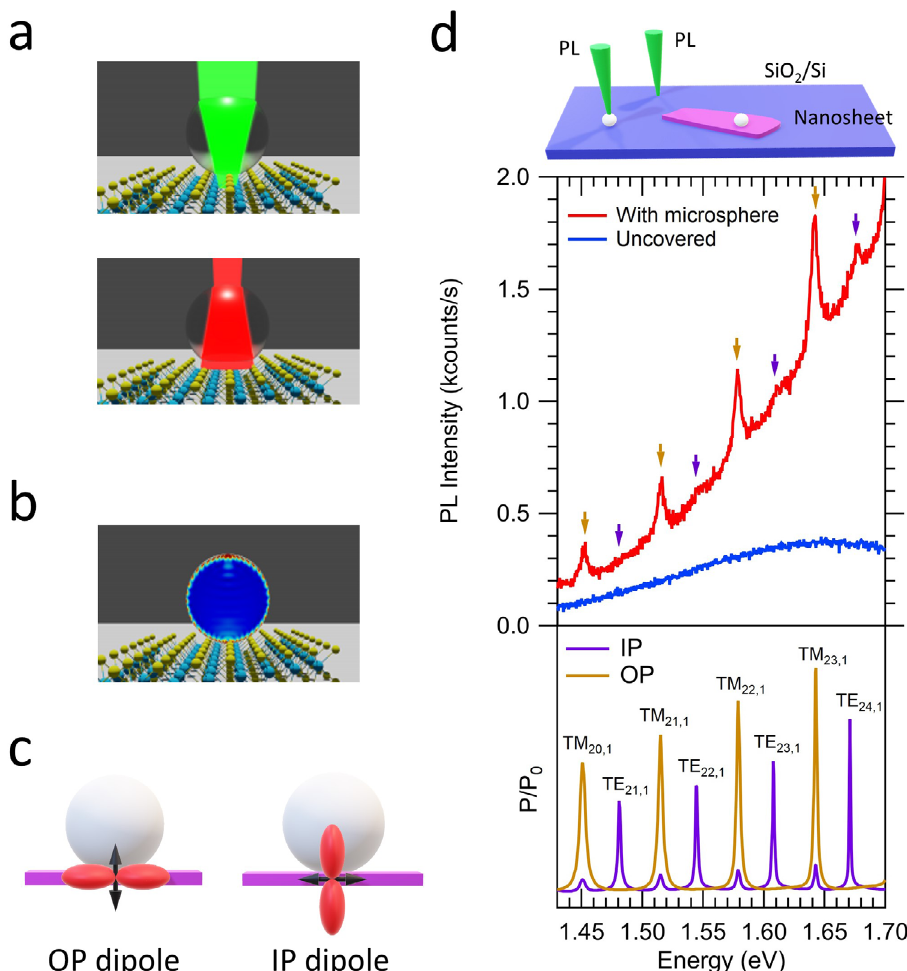
Fig. 2 Optical properties of whispering gallery modes in dielectric microspheres. a Illustration of the focusing effects of the incident (top panel) and emitted light (bottom panel) produced when a dielectric microsphere is placed on top of an emitting layer. b Illustration of an eventual WGM excited by the coupling of emitted light with the modes of the microspherical resonator. c Illustration of the two possible orientations of radiative dipoles that may excite WGMs in the dielectric microspheres on top. Red lobes illustrate dipolar far- fi eld intensity in free space. d Micro-PL spectra measured in an amorphous SiO 2 /Si substrate which contains native radiative centers spread within the SiO 2 overlayer. The μ -PL spectra of these centers have been recorded on points of the SiO 2 /Si substrate with and without dielectric microspheres on top (see illustration depicted on the plot). Comparing these two μ -PL spectra, only the one measured in the point covered with a microsphere shows the presence of quasi-equally spaced peaks due to the coupling of the light emitted excitation of WGMs of the microsphere. The lower panel of the plot shows the spectral response response of the normalized power calculated for a dipolar emission coupled to the WGMs of a spherical dielectric microresonator of index of refraction 1.45 and 4.66 μ m in diameter, when these emitting dipoles are IP (purple curve) or OP (orange curve) oriented, as it has been illustrated in c . The TM or TE character of each WGMs has been indicated on each resonance peak, as referred to the radial component of the vector fi